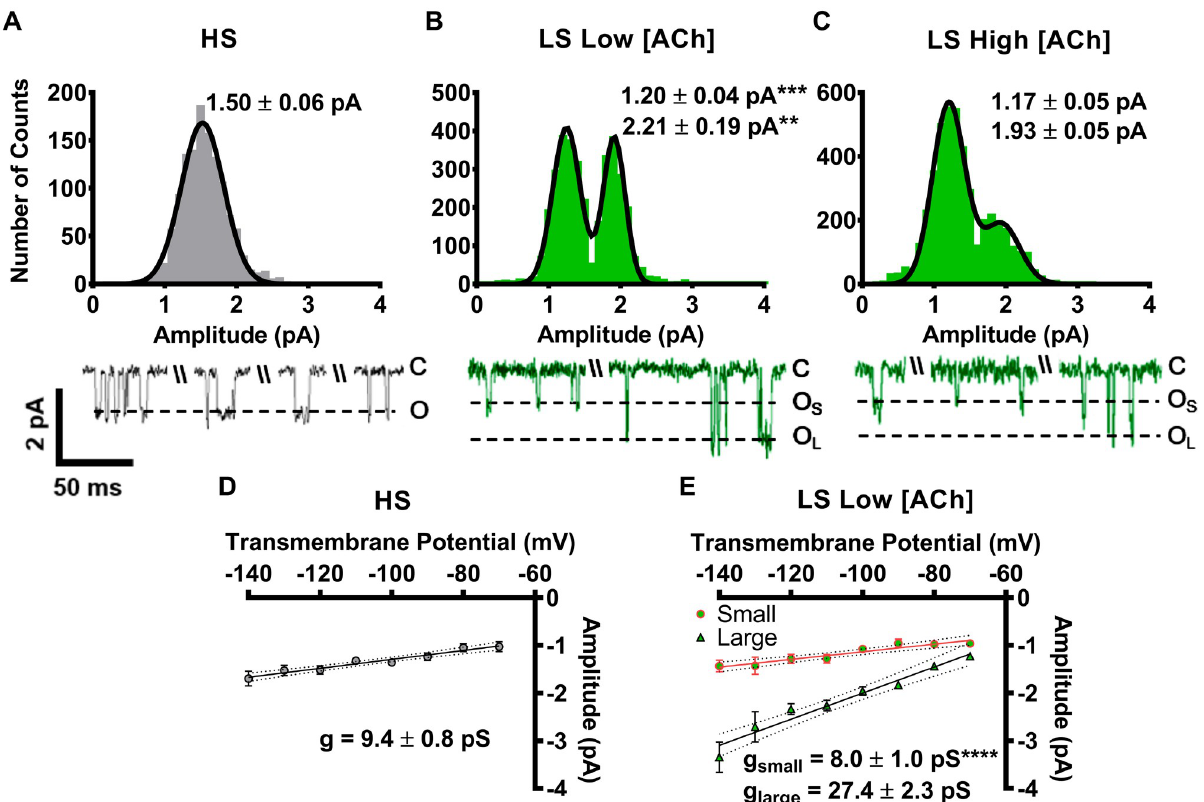
Fig 2. Unitary amplitudes and conductances associated with human HS ( α 4 β 2) 2 β 2-nAChR and LS ( α 4 β 2) 2 α 4-nAChR expressed in X . laevis oocytes from unlinked subunits. (A) HS ( α 4 β 2) 2 β 2-nAChR (grey bars) open amplitudes were found to fall into a single population. (B) LS ( α 4 β 2) 2 α 4-nAChR (green bars) single channel openings were recorded in the presence of a low ACh concentration (0.7 μ M). Under these conditions, openings exhibited two characteristic amplitudes (small and large). Both the small and large amplitudes were significantly different than that associated with opening of HS ( α 4 β 2) 2 β 2-nAChR (F 2,17 = 12.38, One-way ANOVA; Tukey’s multiple comparison test indicates �� P < 0.01, and ��� P < 0.001). (C) LS ( α 4 β 2) 2 α 4-nAChR stimulated with a high ACh concentration (30 μ M) also displayed two distinct amplitudes, which were statistically indistinguishable from those recorded in panel (B), using a low ACh concentration (two-tailed unpaired Student’s t-test were applied to each amplitude class; df = 11–13 and P > 0.05 in each case). Amplitude histograms are all of the events for each construct and ACh concentration collected from individual single-channel patch recordings. Example traces are shown below panels (A), (B), and (C), exhibiting a typical mixture of individual openings and short bursts of activity, interspersed with longer periods of inactivity. (D) Single channel slope conductance was calculated for openings of HS ( α 4 β 2) 2 β 2-nAChR by calculating the mean single-channel amplitude across several transmembrane voltages. (E) The single-channel slope conductances associated with small and large openings of LS ( α 4 β 2) 2 α 4-nAChR (g small and g large , respectively) were also significantly different from each other ( ���� P < 0.0001; two-tailed unpaired Student’s t-test, df = 6). The conductance value g small was similar to that associated with openings of the HS isoform. Values are given as mean ± S.E.M, and were collected from 5–9 patches across a minimum of three separate experiments. All recordings were performed 3—6d following cRNA